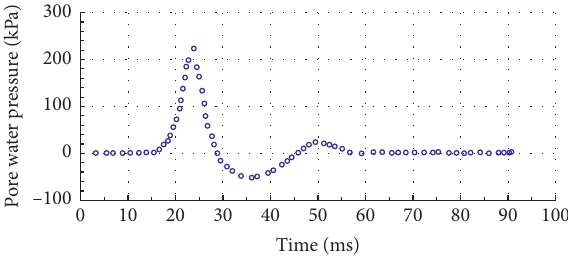
Figure 9: The pore water pressure curve varying with